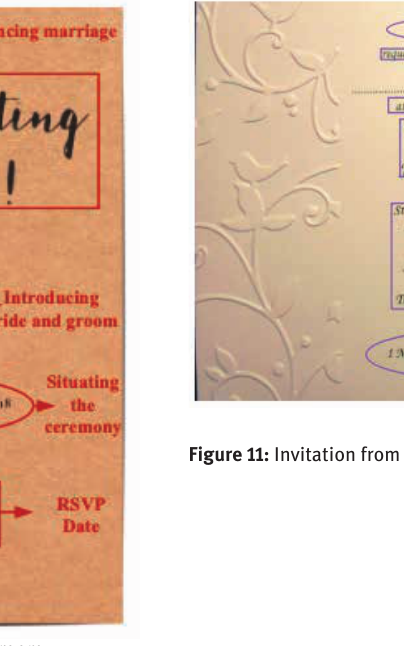
Figure 10: Invitation from Bride and Groom